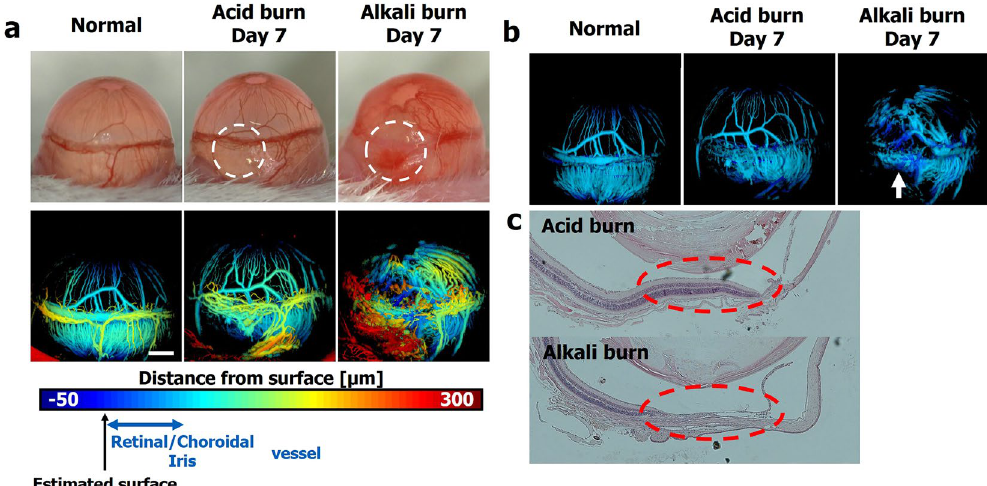
Figure 4. ( a ) Representative photograph images (upper row) and surface-based depth-encoded images (lower row) taken from the untreated eye, and eyes seven days after acid burn and alkali burn. The burned areas are highlighted with white dashed circles. ( b ) Images after surface vessel isolation from the surface-based depth- encoded images. ( c ) Histological sections from eyes after acid burn (upper panel) and alkali burn (lower panel). The burned areas are highlighted with red dashed circles. Scale bar: 500 μ